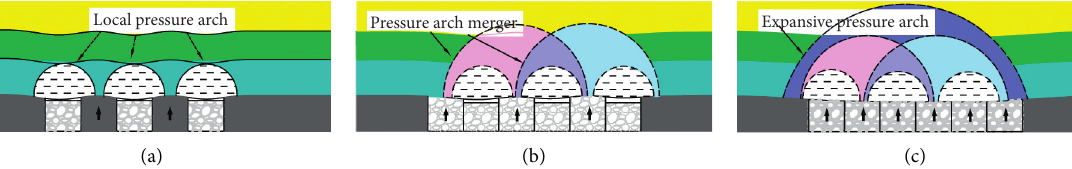
Figure 3: The evolution process of the expanding pressure arch in RBM. (a) Local pressure arch. (b) Merging pressure arch. (c) Expansive pressure